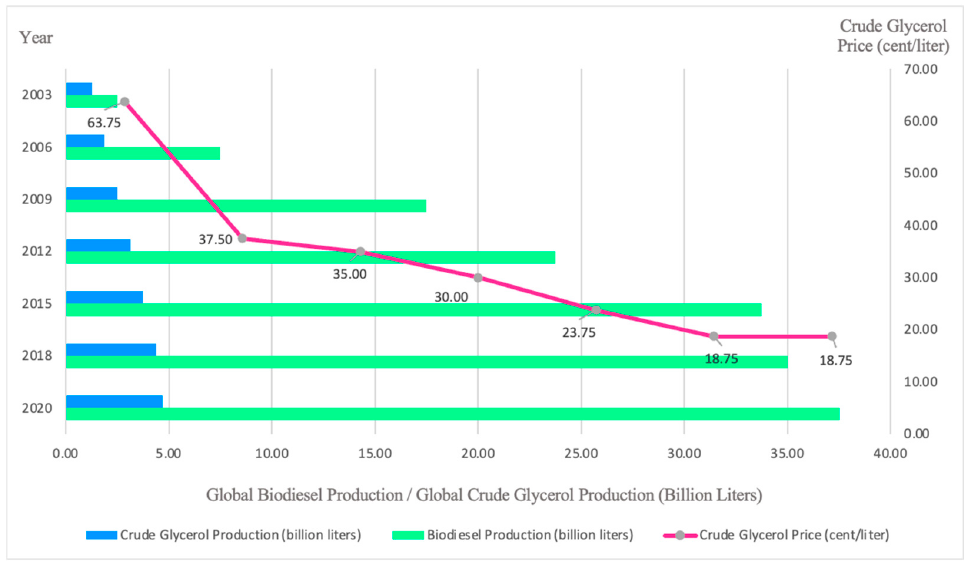
Figure 1. Global biodiesel production and crude glycerol price [11].